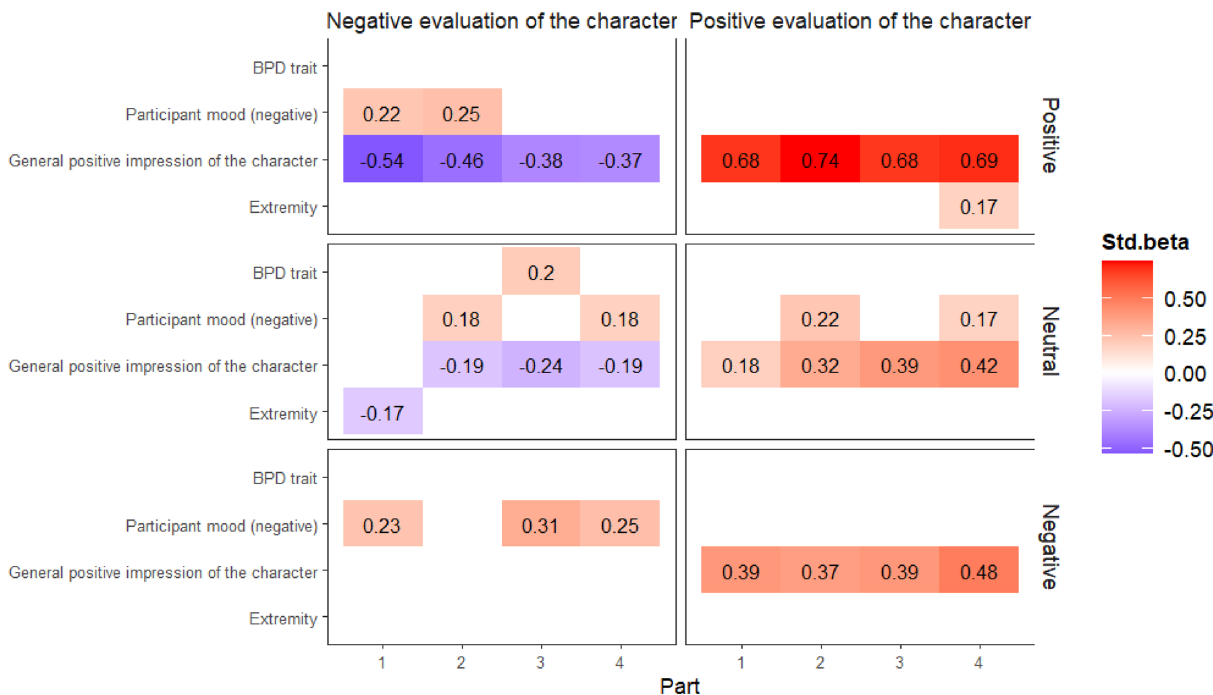
Figure 4. Predictors of character evaluation at each point of assessment by video valence. Note : “Part” refers to the time of measurements, which took place at intervals of approximately 2 days. Values are standardised betas from linear regression models. Only the significant predictors are shown; p values were adjusted using FDR correction. In total, 24 separate models were conducted. The outcome variable was either the positive evaluation of the character or the negative evaluation of the character. Models were conducted separately by video valence (positive, neutral, or negative) and by time. We used BPD trait, participants’ negative mood, the general positive impression of the character, and the extremity of the responses as